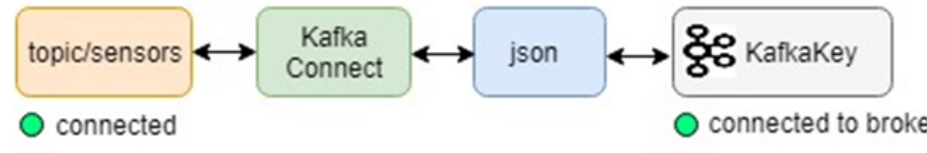
Figure 8. Node-Kafka-broker data pipeline programming flow